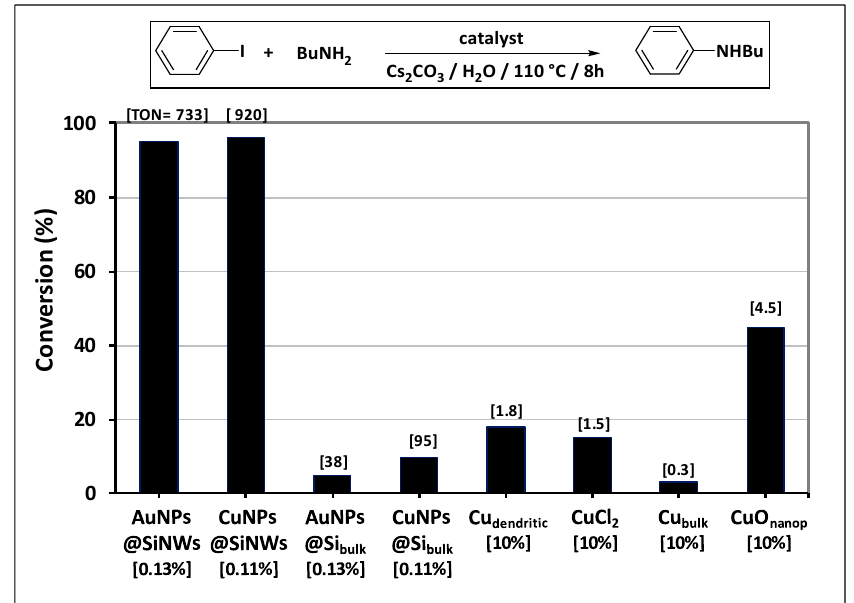
Figure 5. Comparison of catalytic performance in the C–N coupling of iodobenzene with butylamine (catalyst concentration is reported in square bracket). CuO nanop. = 33 nm in size (Sigma–Aldrich) [54], Cu bulk = Cu powder (Sigma–Aldrich). Cu dendritic = dendritic Cu (3 µm in size, Sigma–Aldrich) (for calculation of turn over number (TON) values see supplementary materials).